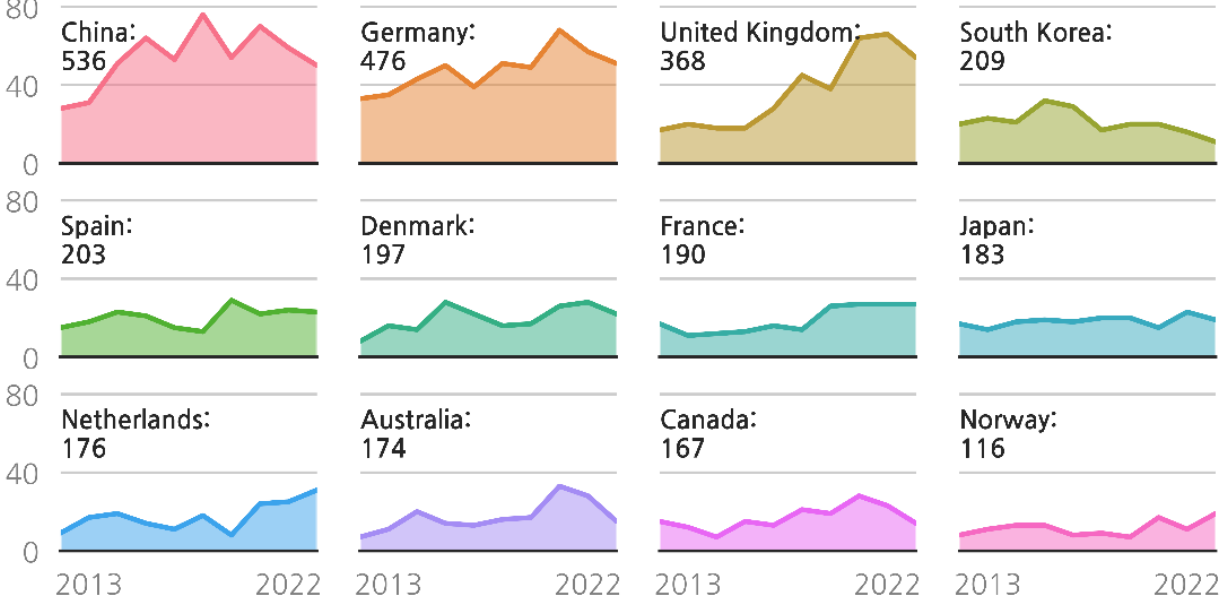
Figure 5. The number of co-authored publications in the top 12 countries. The number of publications with the NREL is annotated beneath the country name.